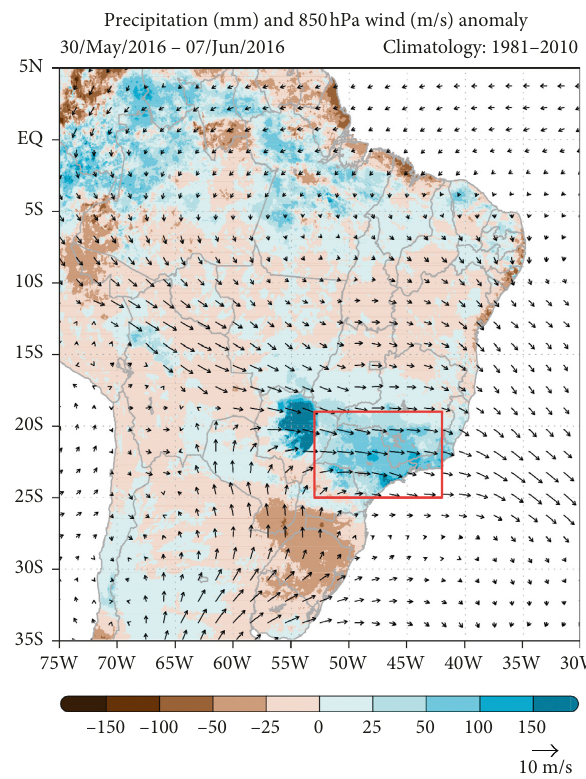
Figure 1: Precipitation anomalies (mm) and 850hPa wind com- 1 ) for May 30 to June 07, 2016. The blue (brown) colors posite (m s · indicate the positive (negative) rain anomalies, and the red box − indicates the area of study. The anomalies were calculated using the 30-year period, 1981 to